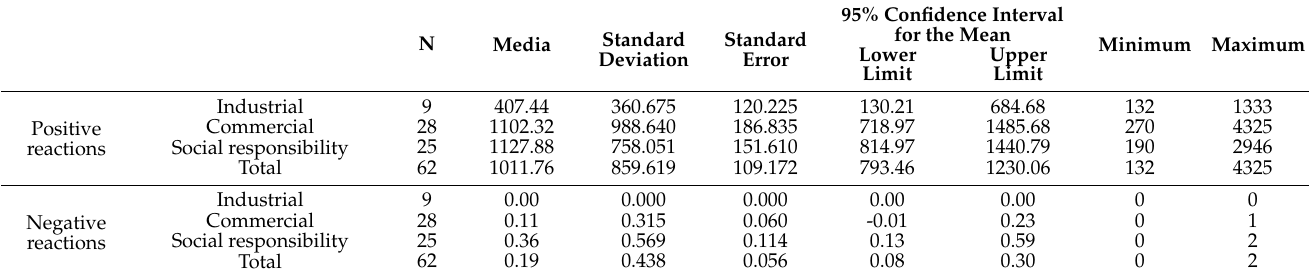
Table 7. Descriptive statistics of the reactions of the follower according to the brand